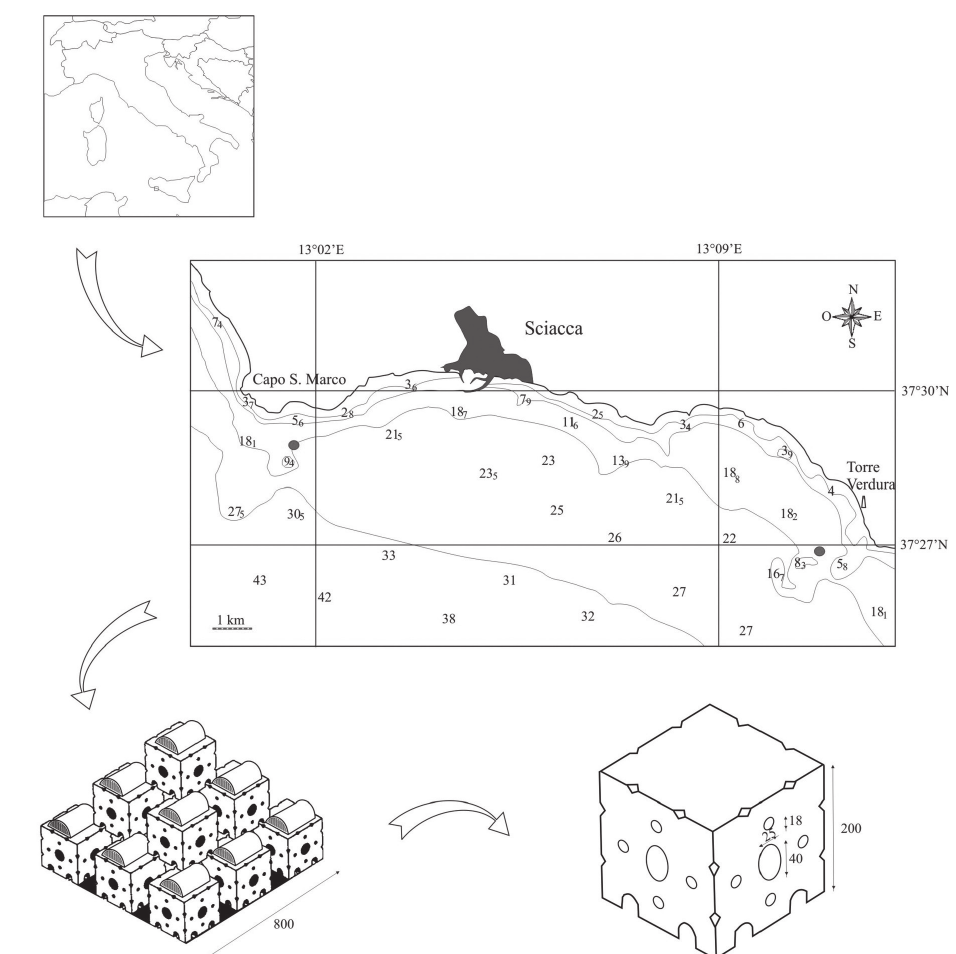
Fig . 1. – Study area and location of the artificial reefs ( filled circles ) off Capo S. Marco and Torre Verdura (Central Mediterranean Sea) with shapes and dimensions (cm) of the reef